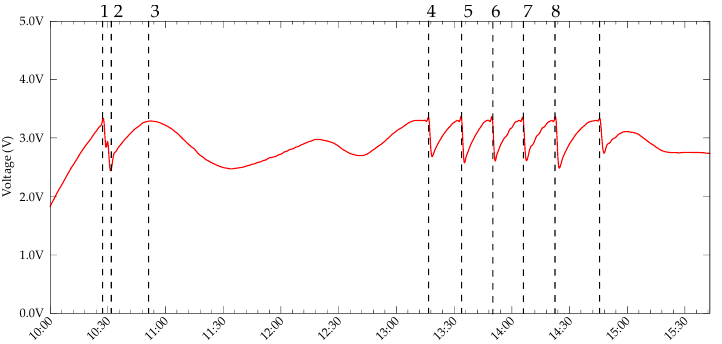
Figure 13. Capacitor voltage recorded for a single day.